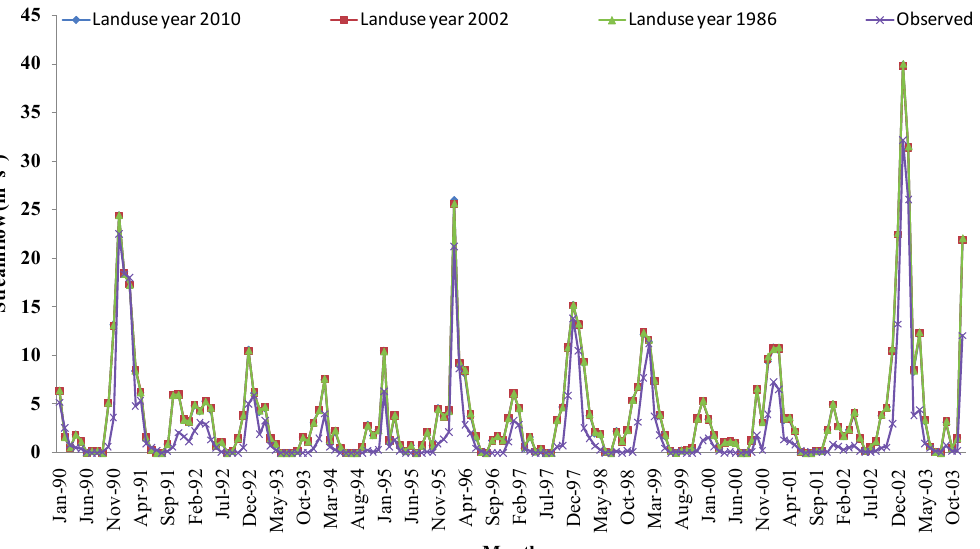
Fig. 5 Comparison between the measured and simulated monthly streamflows for the different land uses.